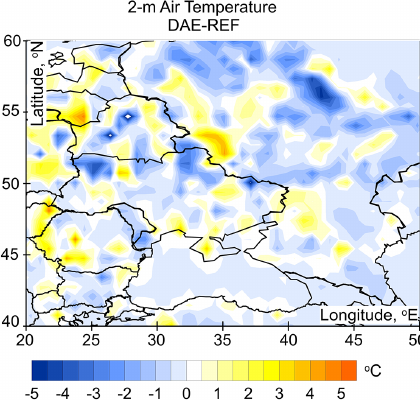
Figure 8. Difference field between the Enviro-HIRLAM DAE and REF model runs for 2m air temperature at 12:00UTC on 14 Au- gust